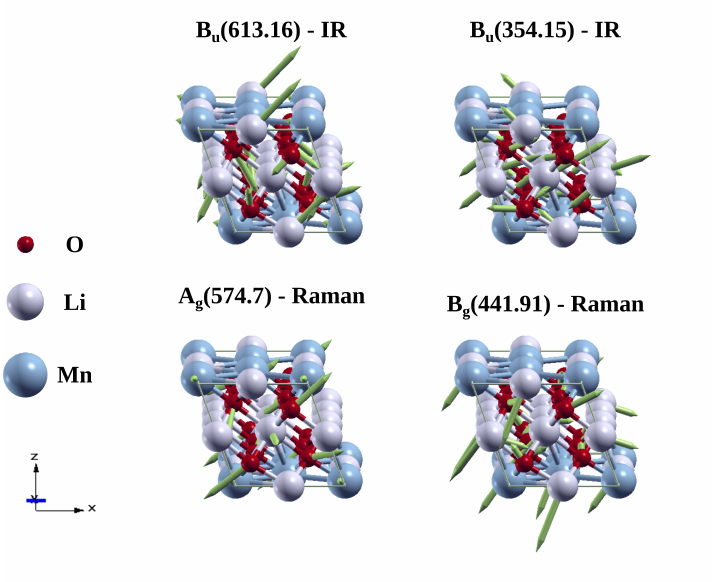
Figure 6. Atomic displacements for representatives IR and Raman vibrations modes of Li 2 MnO 3 calculated by